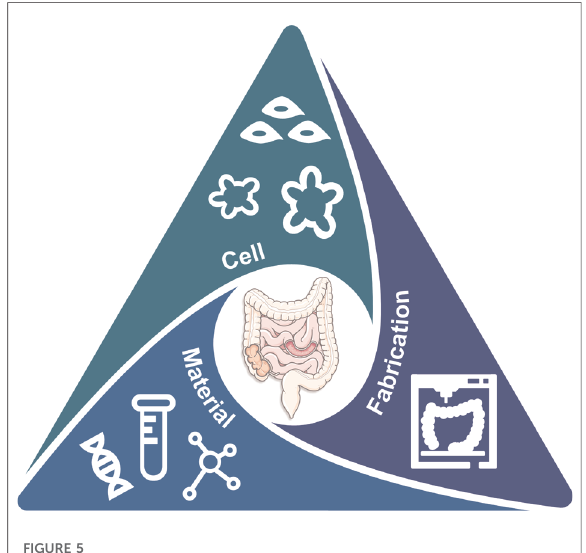
FIGURE 5 The TE trinity toward advanced in vitro gut model for GBA: cell, material, and